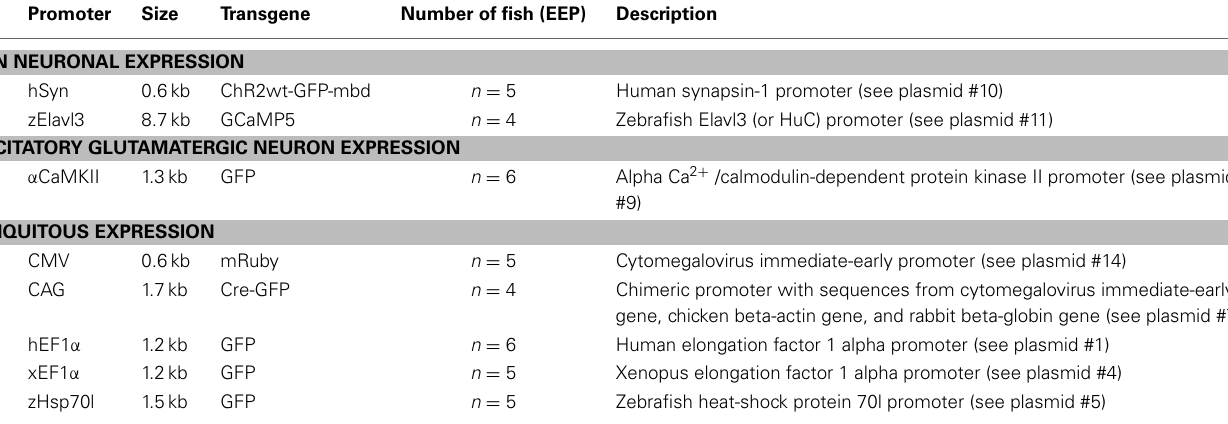
Table 4 | Promoters compared by